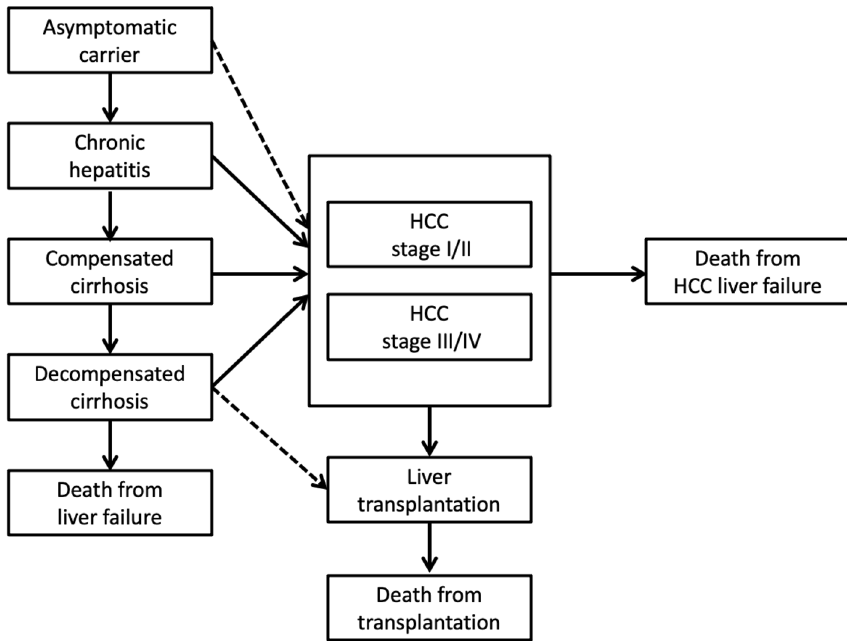
Figure 2. Model structure of chronic hepatitis B-related diseases.